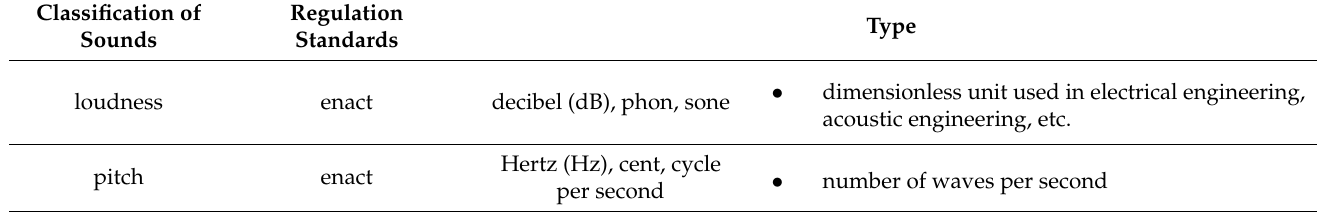
Table 6. Sound regulation standard status and types of